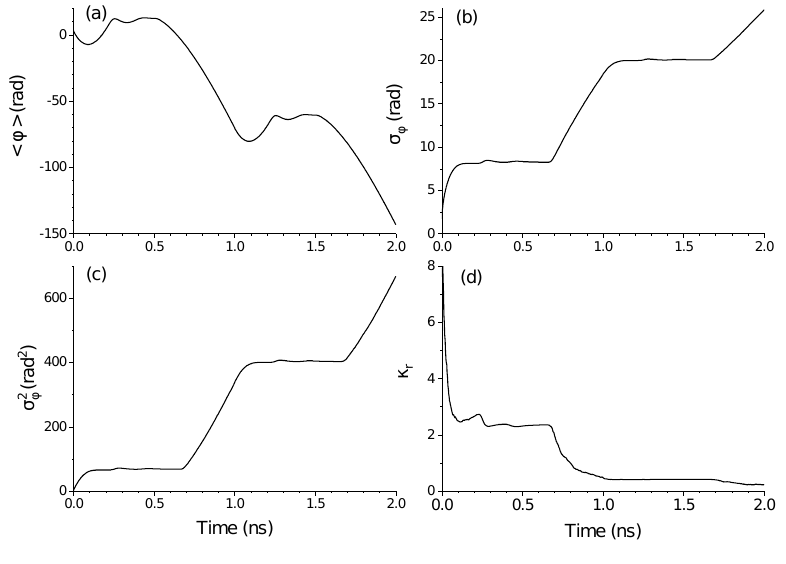
Figure 7. ( a ) Average, ( b ) standard deviation, ( c ) variance, and ( d ) kurtosis coefficient of the phase as a function of time for a two-period window with T = 1